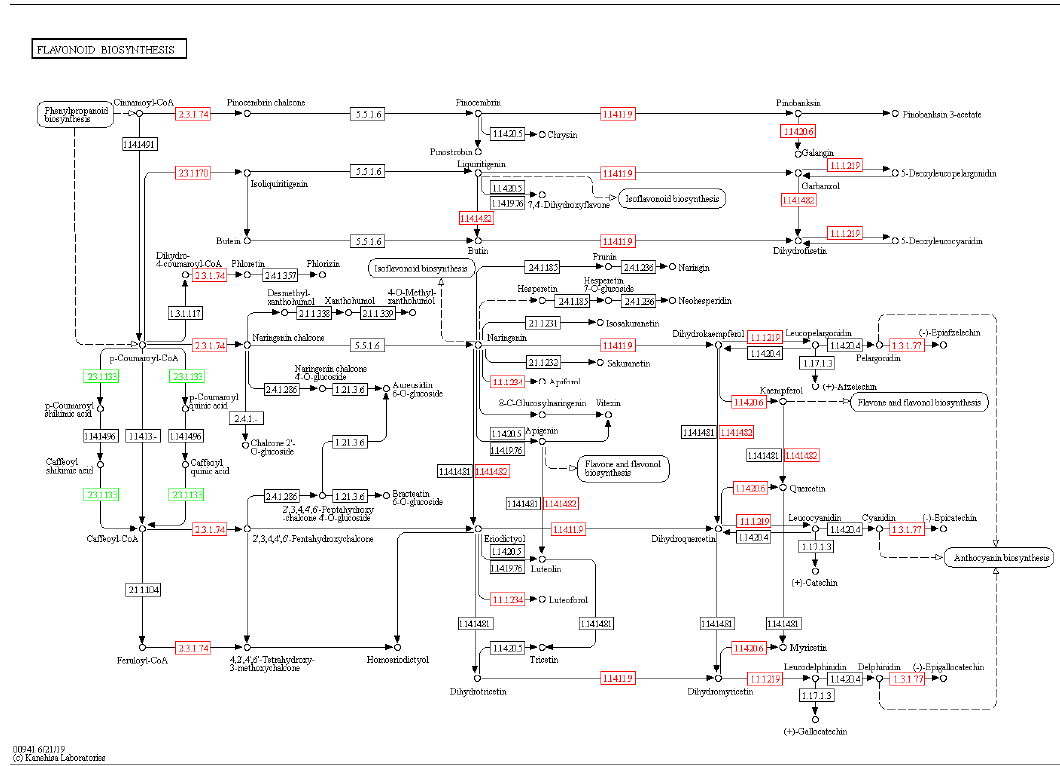
Figure 12. Flavonoid biosynthesis in C. oleifera leaves under different light conditions. The red color represents up-regulated unigenes under blue light conditions compared with red light; the green color represents down-regulated unigenes under blue light conditions compared with red light.